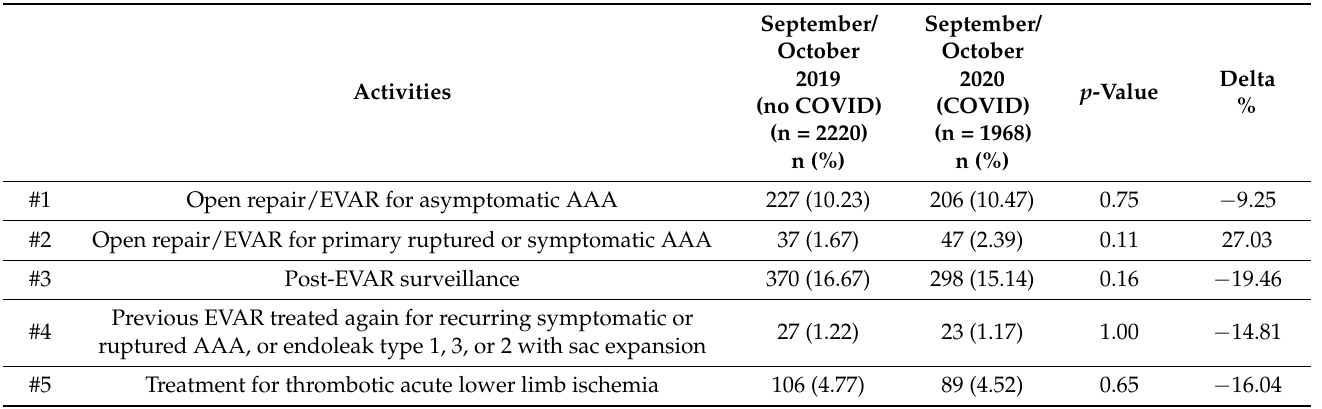
Table 6. Summary of the responses to the questionnaire for the COVID-19 months of